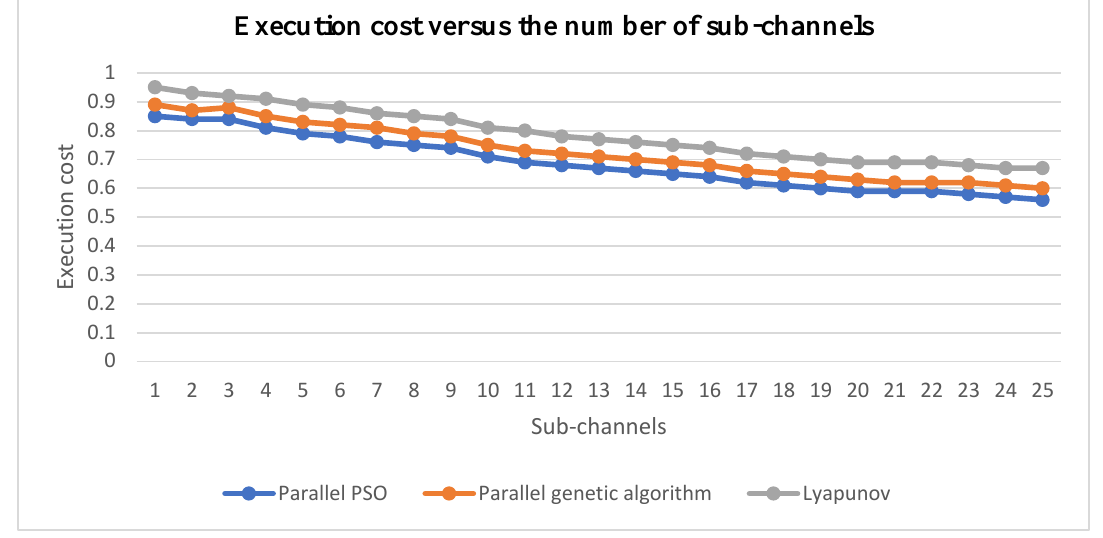
Figure 4. Execution cost comparison.